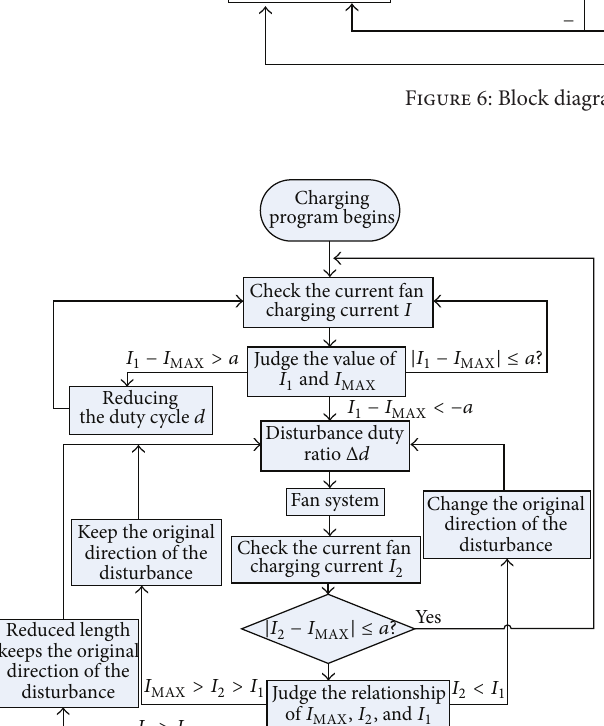
Figure 7: Flow chart of MPPT using climbing mountain method.